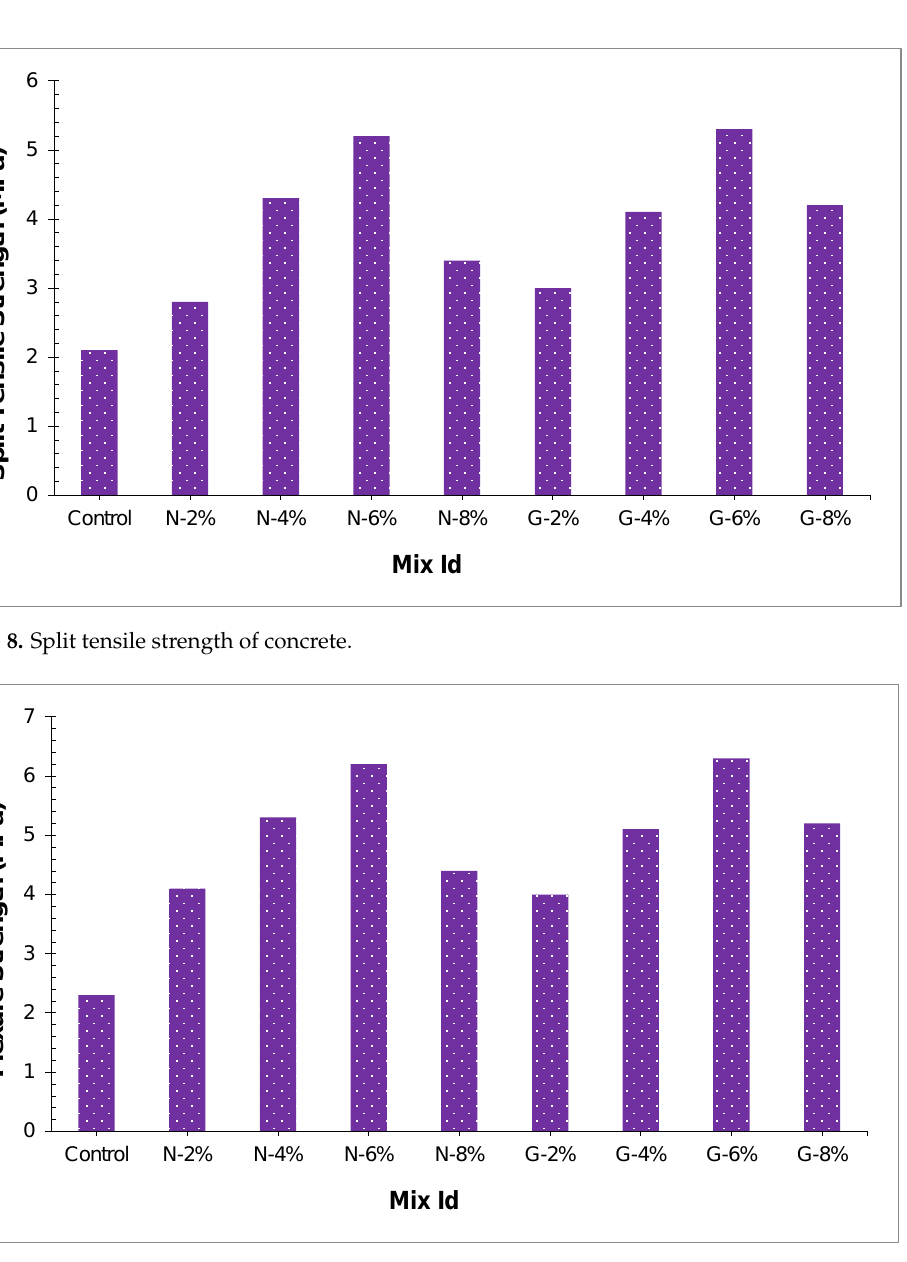
Figure 9. Flexural strength of concrete.